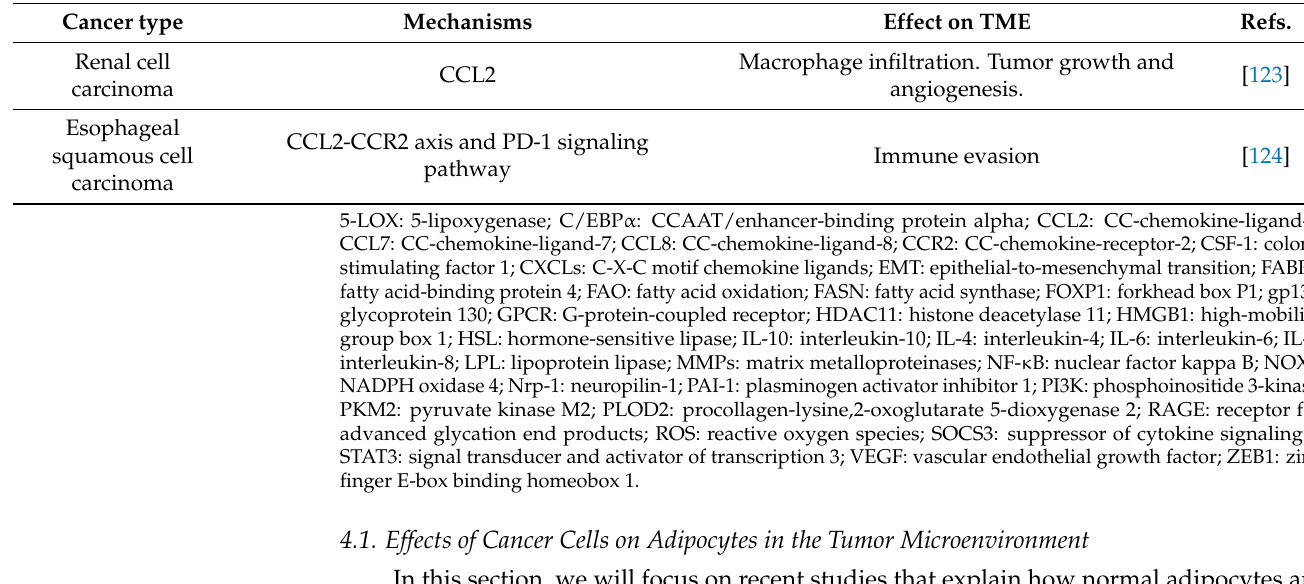
Table 3. Cont. Signals from Cancer Cells to